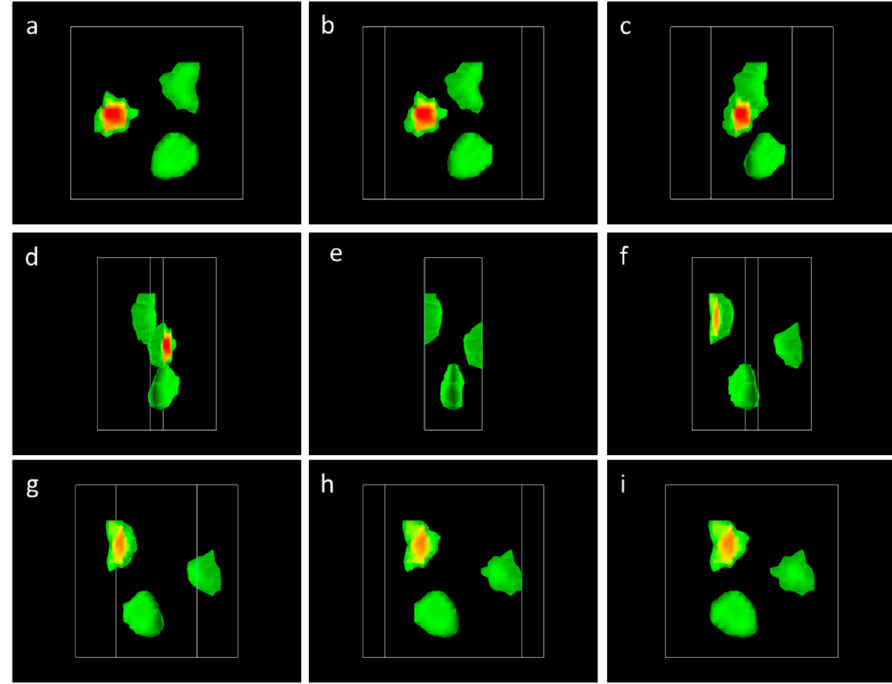
Figure 12. ( a – i ) Consecutive shots of the reconstructed image of the nuclear resonant attenuation (pure NRF) captured from the visualized three-dimensional movie.